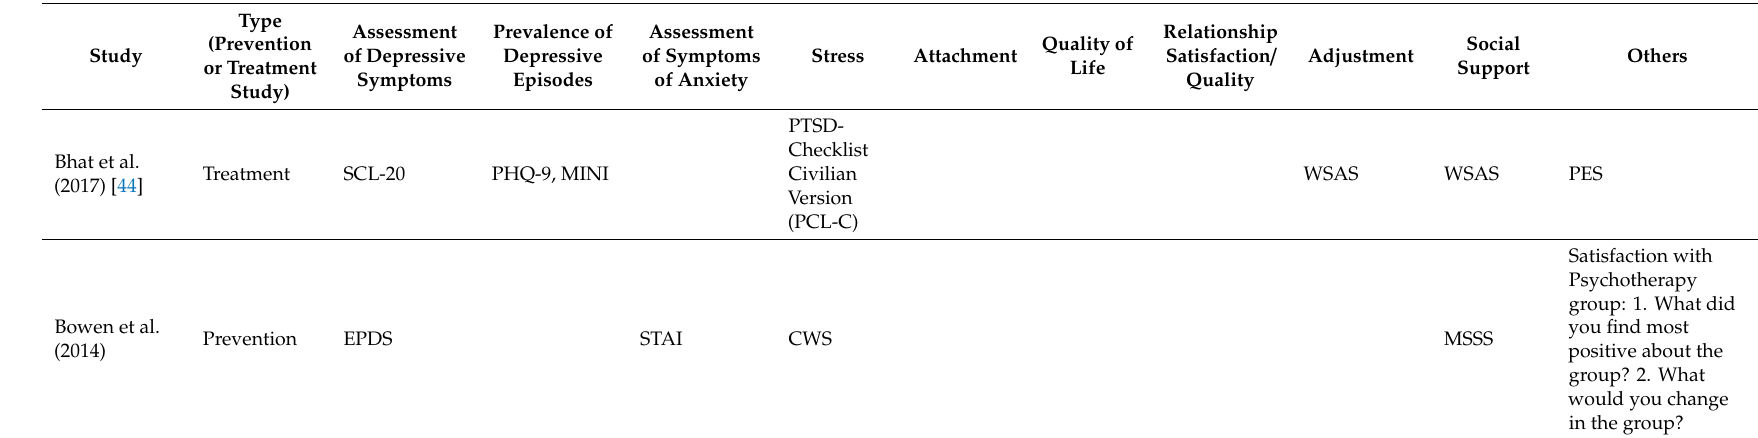
Table 3. Method of Assessment for Outcomes in Included